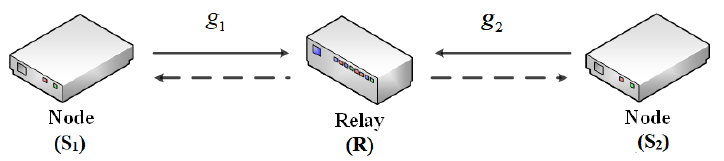
Figure 1. System